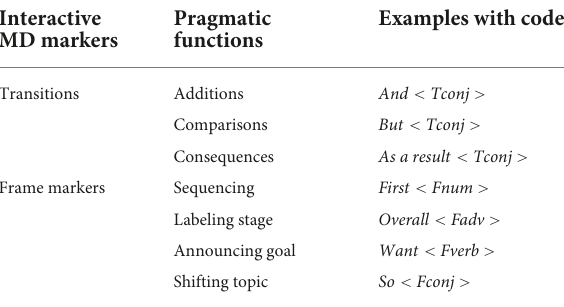
TABLE 2 Pragmatic functions of interactive metadiscourse